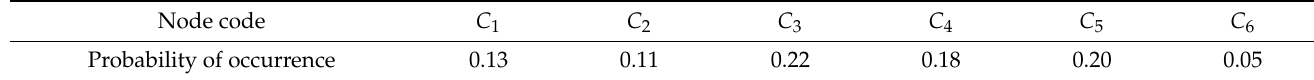
Table 9. Priori probability of exogenous